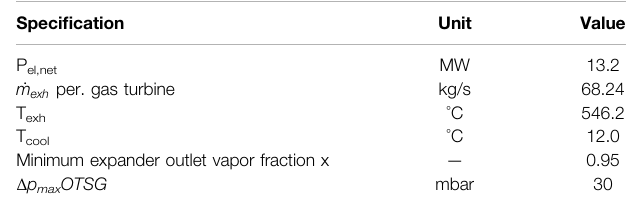
TABLE 2 | Input speci fi cations used for process design